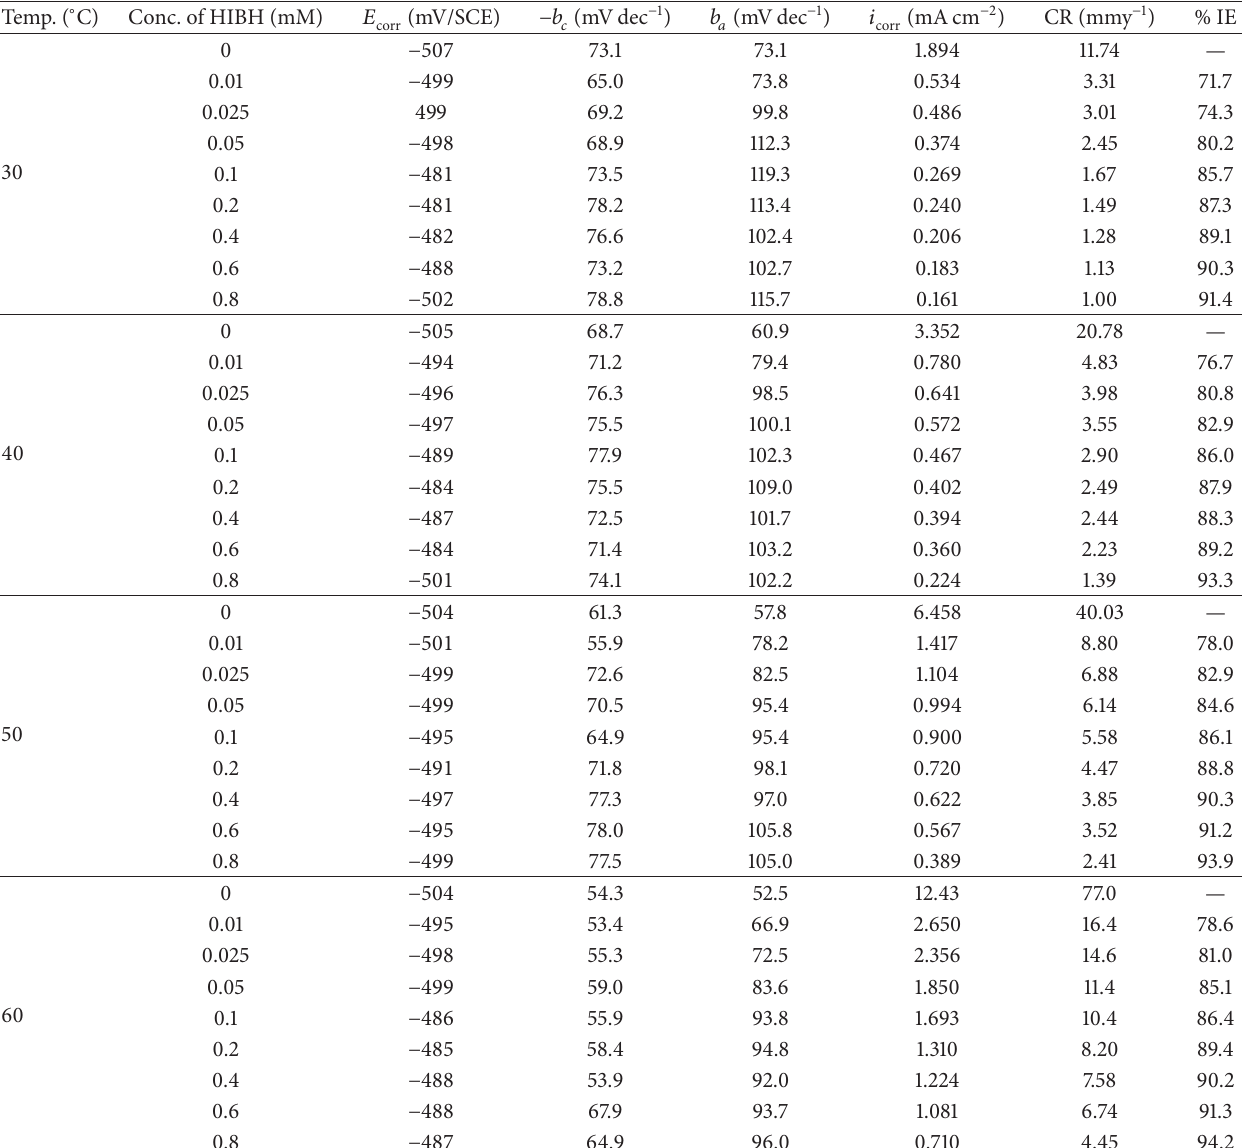
Table 1: Tafel polarization results for the corrosion of mild steel in 1 M HCl in the absence and presence of inhibitor at different temperatures. Temp. ( ∘